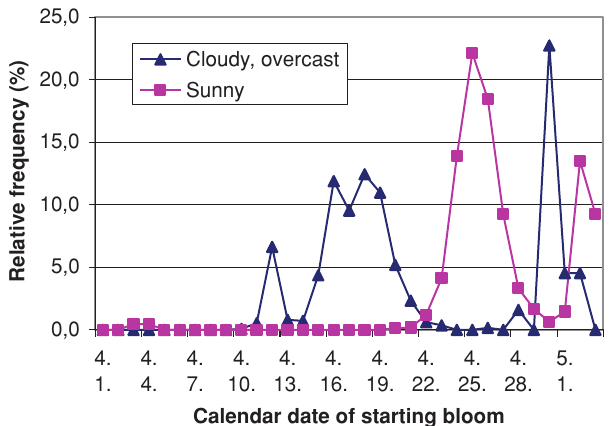
Figure 3. Distribution of the beginning of blooming time in cloudy and